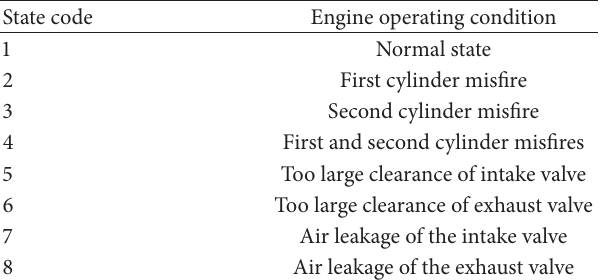
Table 1: Engine operating states in